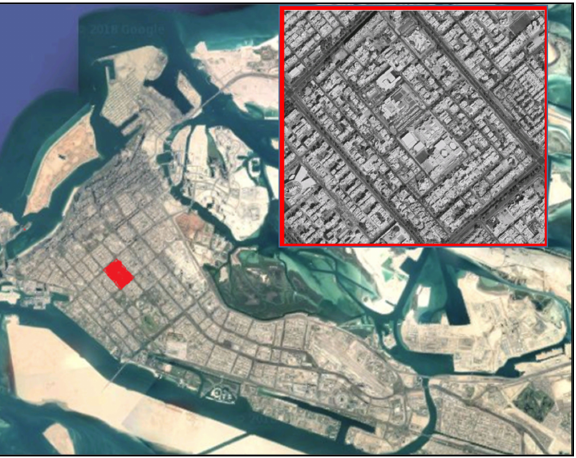
Figure 2. Map image showing the aerial view of structures within the sample region considered in Abu Dhabi city.